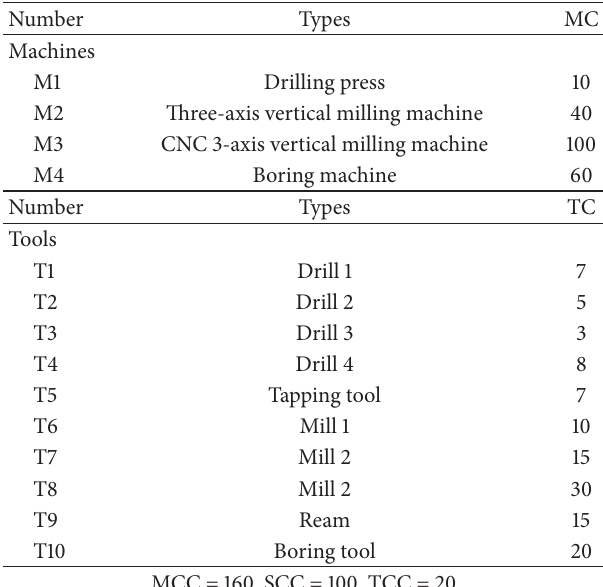
Table 8: Available machining resources and costs in a workshop